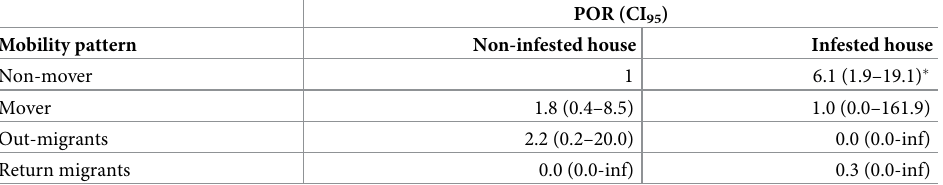
Table 1. Prevalence Odds Ratios (POR) of the effects of the interaction between mobility patterns and house infestation on child seropositivity for T . cruzi infection in 2008, Pampa del Indio, Argentina. The interaction anal- ysis was included in a generalized linear mixed model clustered by household and adjusted for age, gender, ethnic group and the mothers’ seropositivity.